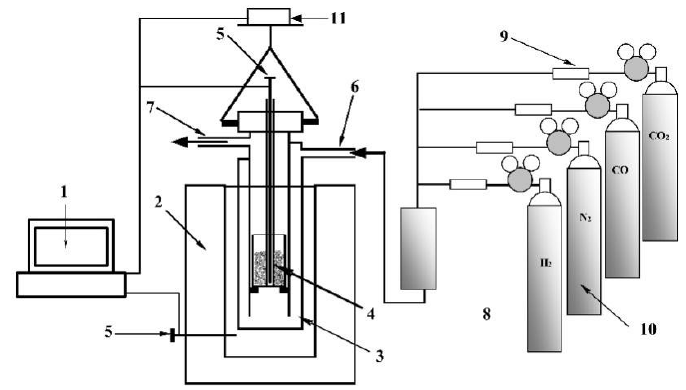
Figure 1. Schematics of experimental apparatus for reduction experiments.